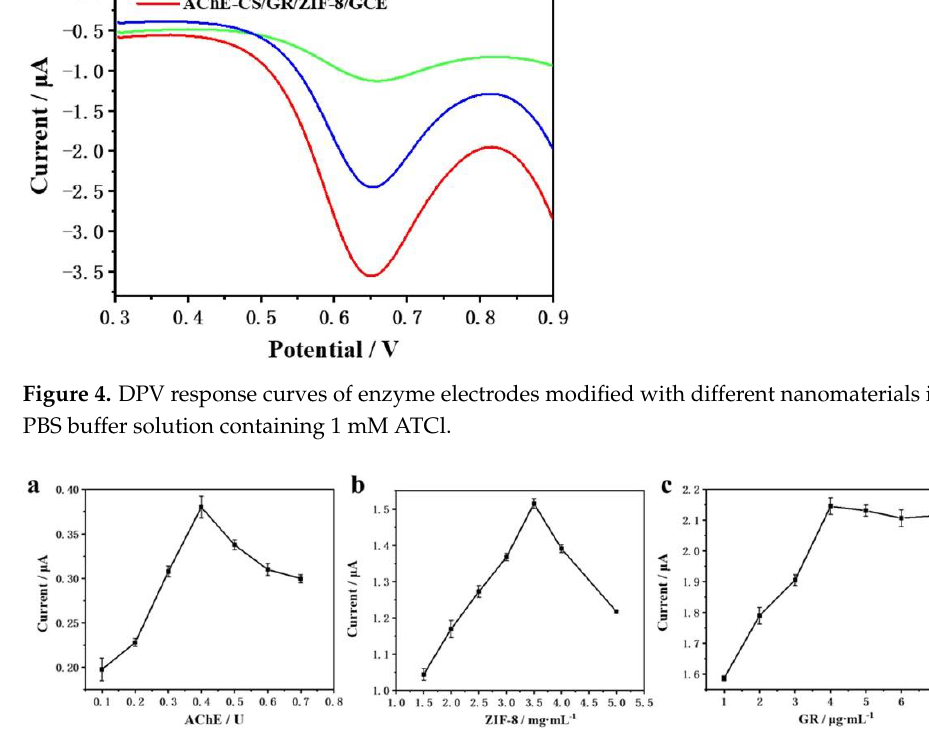
Figure 5. The trend of the response current of different sensors to 1 mM ATCl of ( a ) different AChE loads, ( b ) different ZIF-8 concentration, ( c ) different GR concentration.